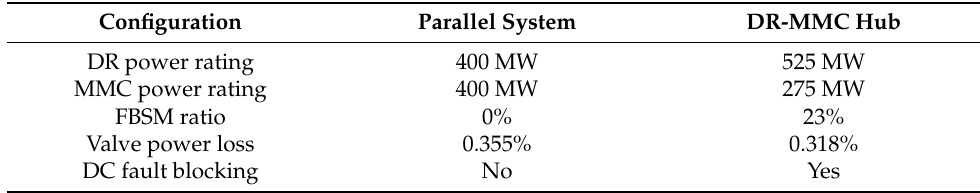
Table 1. Comparison between the two different configurations.